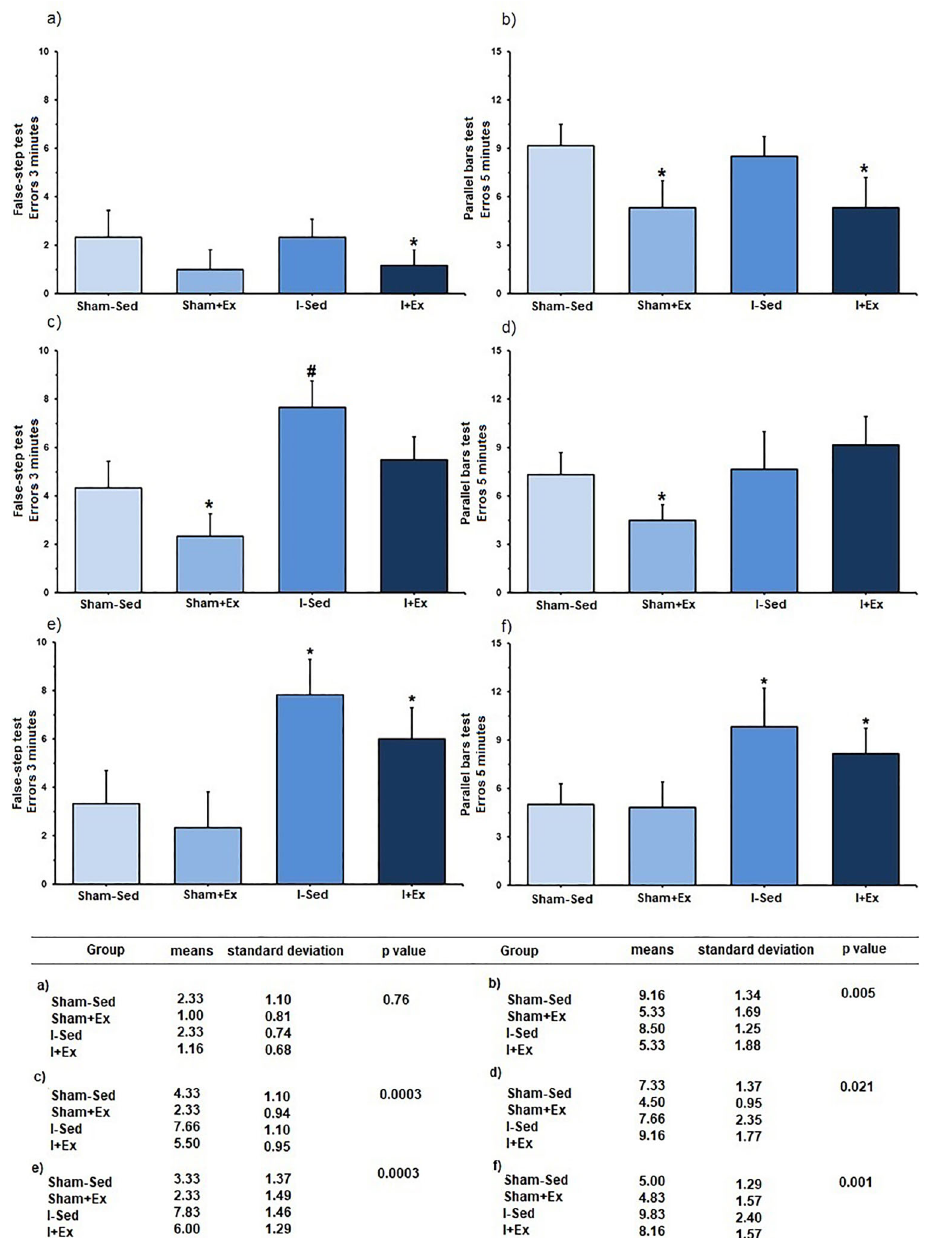
Figure 2. Evaluation of motor performance and table with numerical data. Errors (mean values) committed by the animals before ( a , b ) and after ( c , d ) the surgical procedures, and prior to euthanasia ( e , f ). a , *P=0.043 vs Sham-Sed group; b , *P=0.005 vs Sham-Sed and I-Sed groups; c , *P=0.0003 vs remaining groups. # P=0.0002 vs Sham-Sed and I + Ex groups; d , *P=0.021 vs remaining groups; e , *P=0.0002 vs control groups; f , *P=0.001 vs control groups (ANOVA, followed by Newman-Keuls post- test). Sham-Sed: Sedentary control group; Sham + Ex: Control group exercised before the sham surgery; I-Sed: Sedentary ischemic group; I + Ex: Ischemic group exercised before occlusion of the middle cerebral artery surgery.